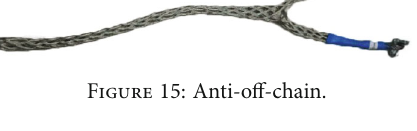
Figure 13: Schematic diagram of ultra-high-pressure clean water pump.